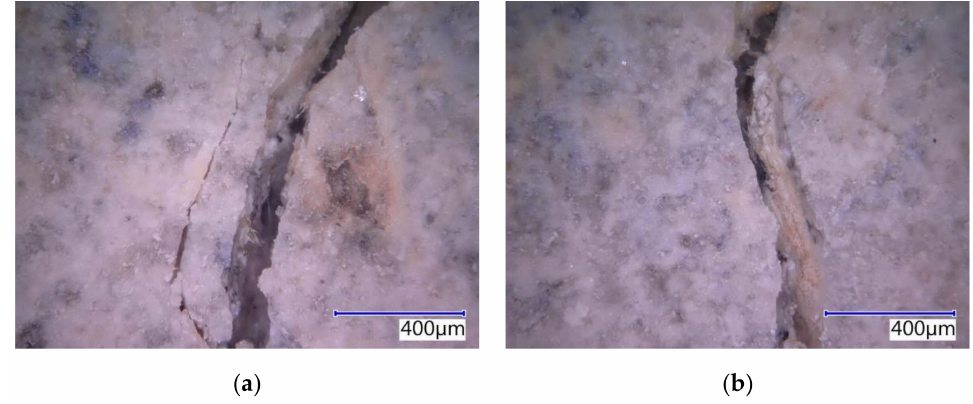
Figure 28. Detailed structure of crack PM-M20—pictures from optical microscope: ( a ) dominant crack with minor crack and defect of matrix and chips; ( b ) deteriorated chip oriented along the crack.